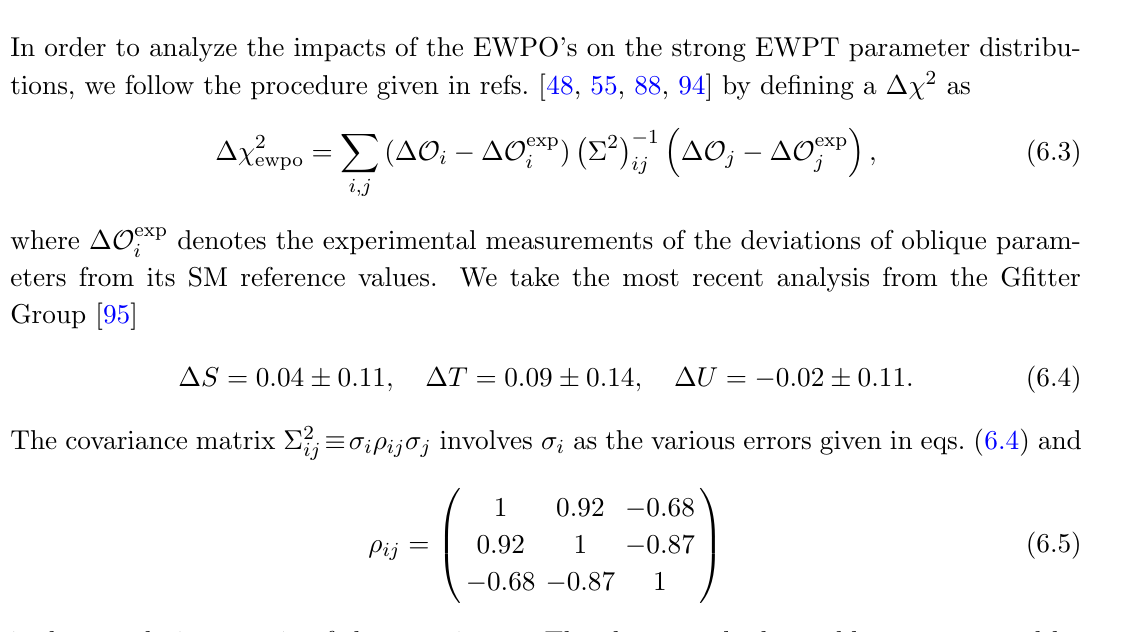
in the m S - (cid:18) ewpo